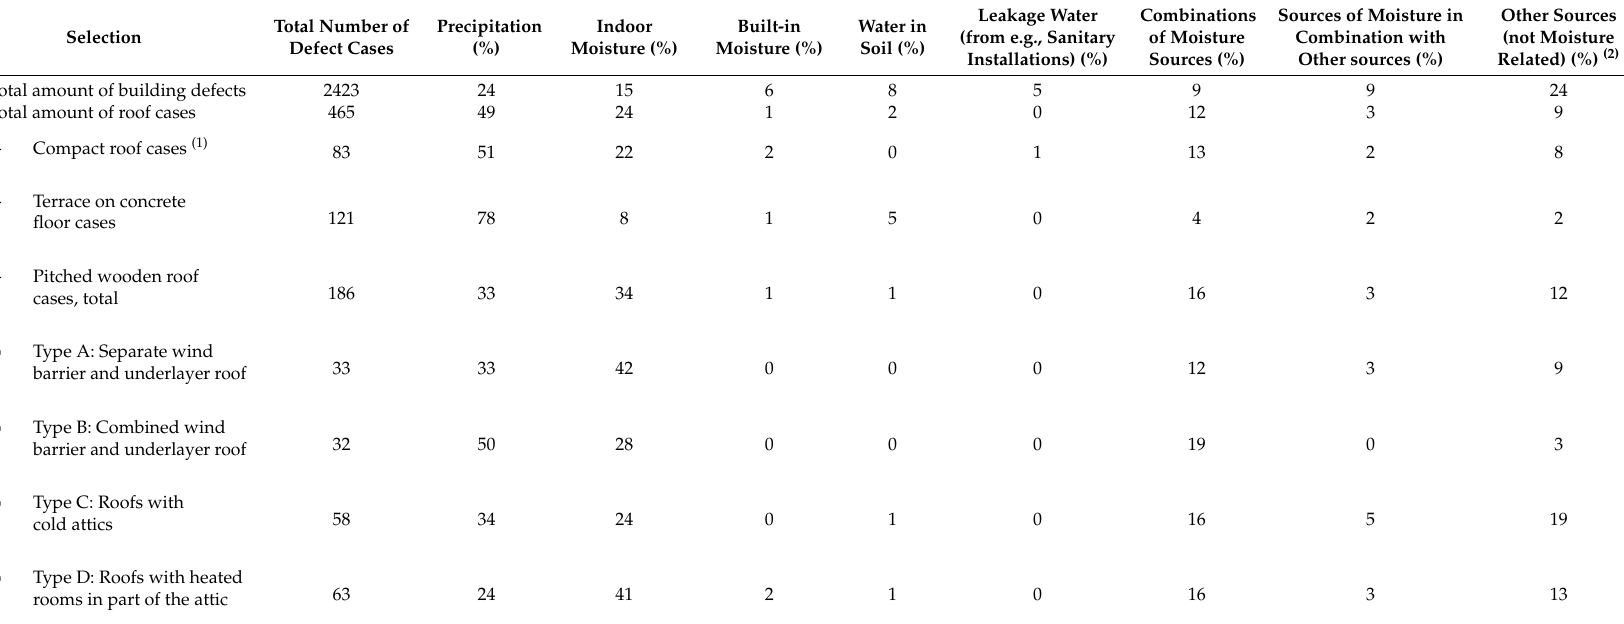
Table 1. Process-induced building defect cases for the 10-year period from 1993–2002, distributed by source of defects (critical